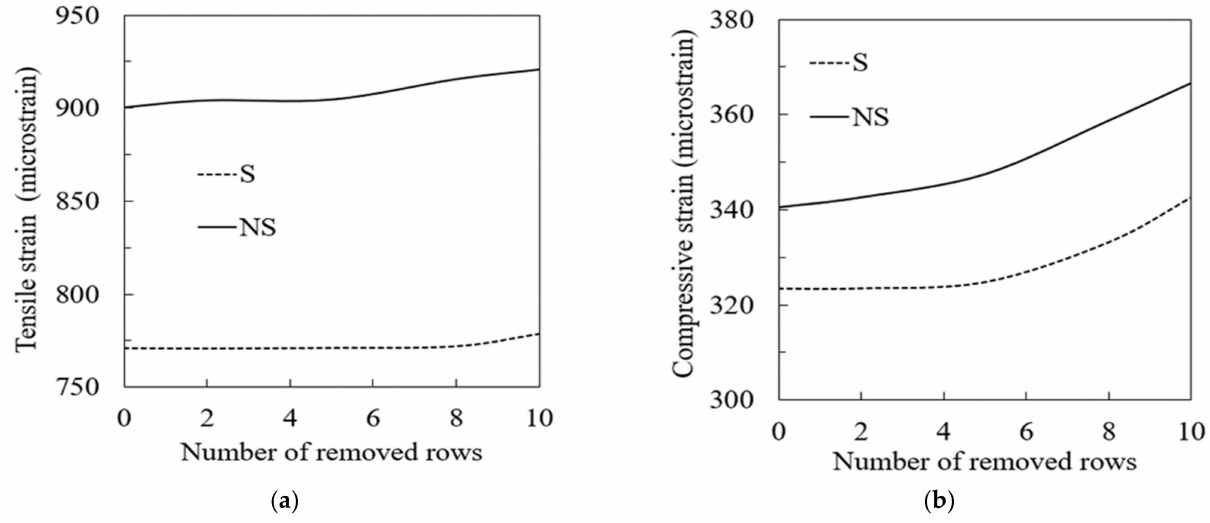
Figure 13. The effect of the progressive failure of studs on the midspan strains at the extreme fibers of the composite section. ( a ) Tensile strains. ( b ) Compressive